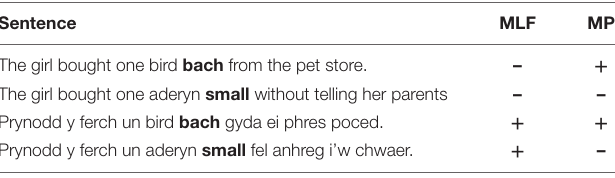
The target word is highlighted in bold. Italics and bold font are for emphasis and were not used in the experiment.